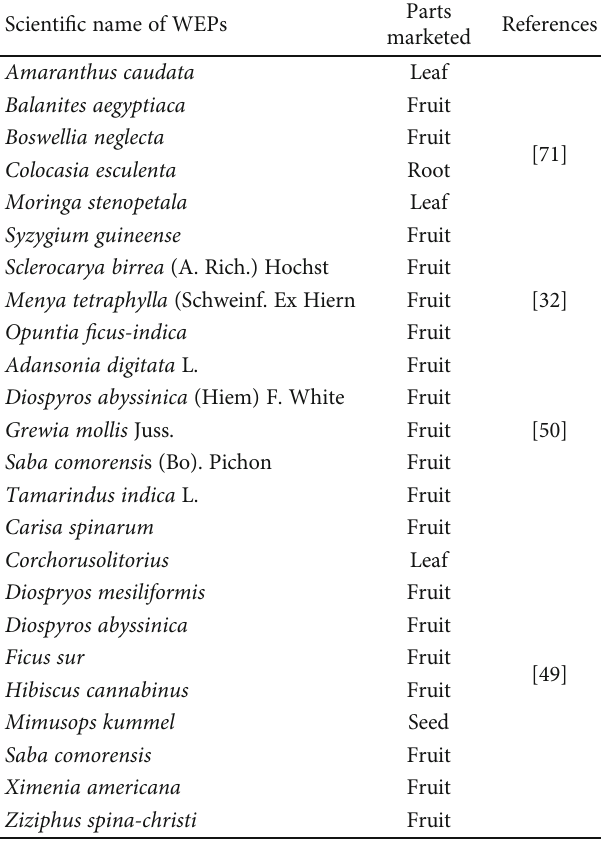
Table 4: List of marketable wild edible